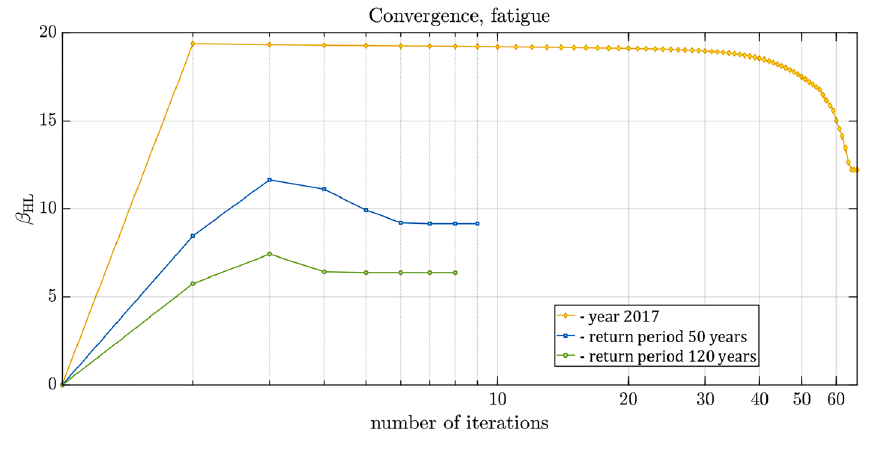
Fig. 13 Convergence for the reliability index 𝛽 , fatigue by EN